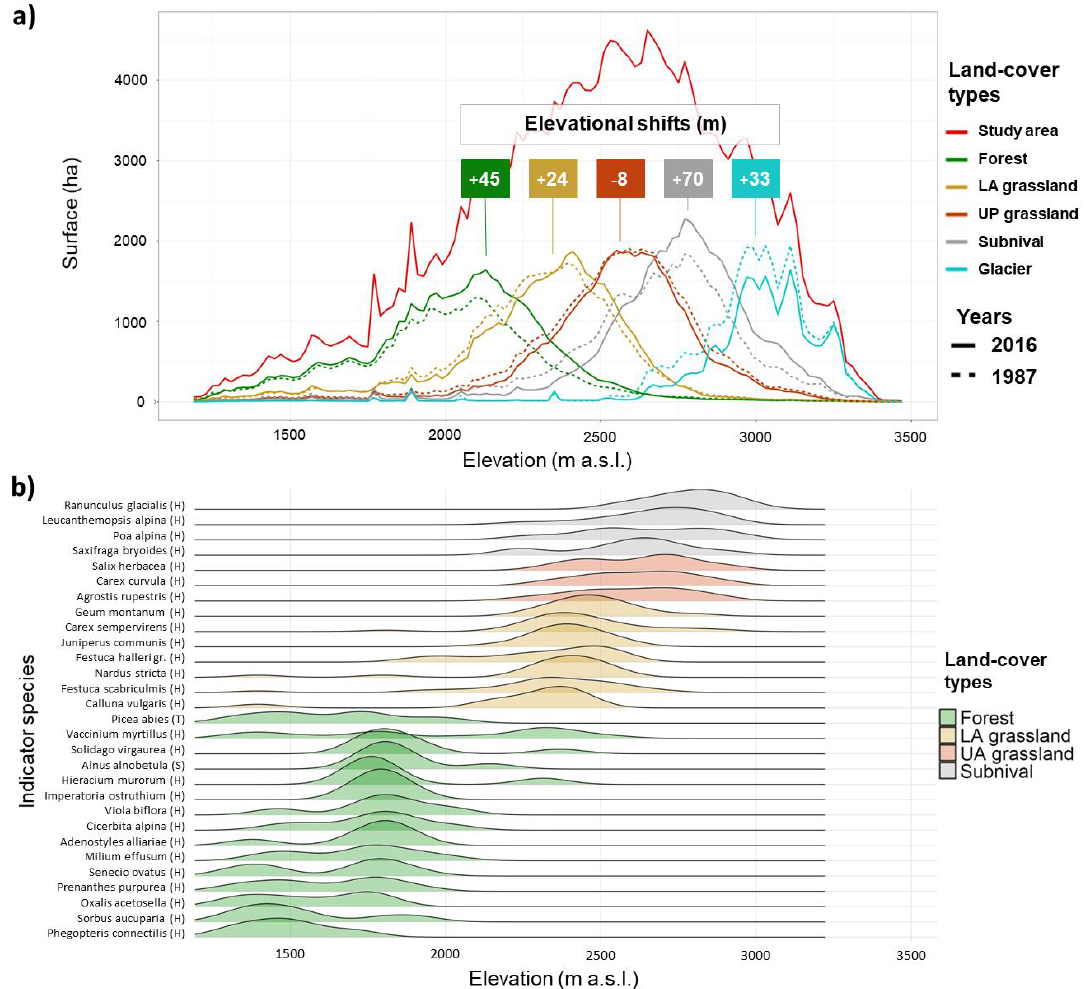
Figure 6. Elevational distribution of land-cover types over time derived by Landsat images and corresponding indicator species for the four vegetation belts derived by field sampling. ( a ) Significant elevational shifts of the occupied surfaces by land-cover types that occurred between 1987 and 2016. Curves were smoothed using 115 elevational breaks of 20 m. ( b ) Density plots of the most significant indicator species ( p -values < 0.001) along the elevational gradient. Species are grouped in vegetation belts following land-cover types. Species layers are provided between brackets (T for tree, S for shrub, and H for herb layers).